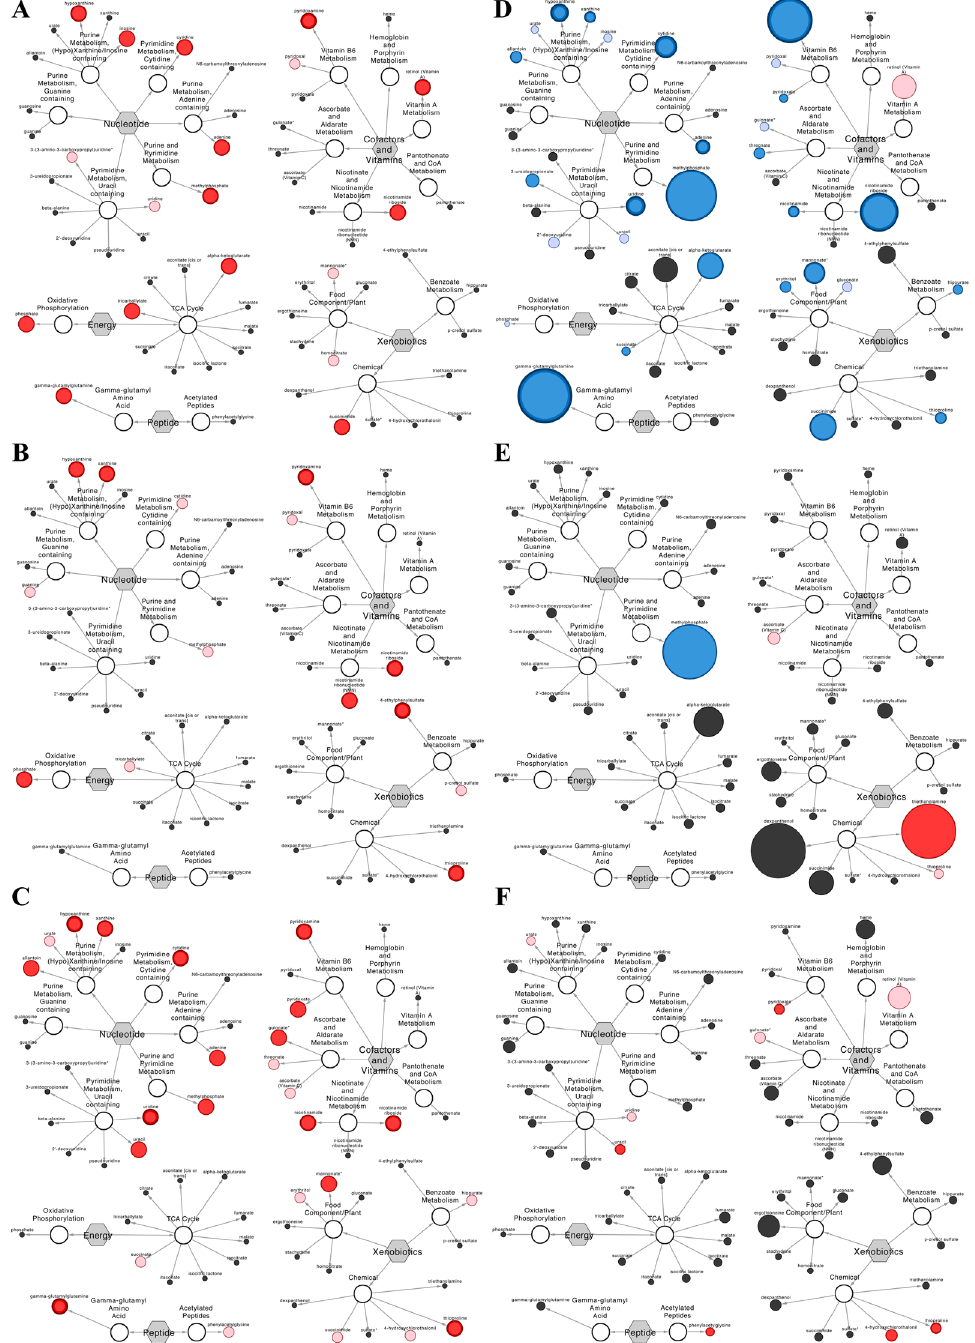
Figure 2. Network comparison of metabolite relative flux in uterine luminal fluid. Networks on the left-hand side show biochemicals which displayed ( A ) a progesterone (P4) main effect, ( B ) a day main effect, and/or ( C ) a day by P4 interaction – i.e . concentrations differed between groups (normal vs . high P4) at different times (Days 12 vs . 13 vs . 14). Significance is represented by node colour and diameter combined: a large dark red node indicates an (p ≤ 0.05) effect/interaction (node border thickness is inversely proportional to the magnitude of the p-value), whereas a medium light red node depicts a trend (0.05 < p < 0.10) towards an effect/interaction, and a small black nodes depict a lack of significance. Networks on the right-hand side compare metabolite flux magnitude in the uterine luminal fluid of normal vs . high P4 heifers on Days ( D ) 12, ( E ) 13, and ( F ) 14. Here, node diameter is proportional to the fold change observed, and node colour represents the significance of the change: dark red depicting a significant (p ≤ 0.05) increase, light red highlighting an increasing trend (0.05 < p < 0.10), dark blue denoting a significant (p ≤ 0.05) decrease, and light blue depicting a decreasing trend (0.05 < p < 0.10). Black nodes depict a lack of a statistically significant flux. In addition to node colour, node border thickness is inversely proportional to the magnitude of the